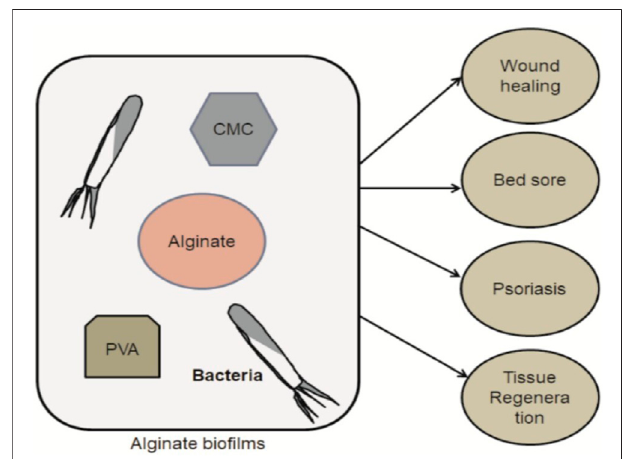
FIGURE 3 | A systematic process of bio fi lm formation.